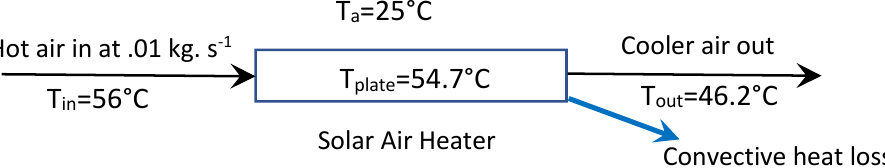
Figure 5. Schematic diagram of mass and energy flows in the experiments for the heat loss measurements in the laboratory.